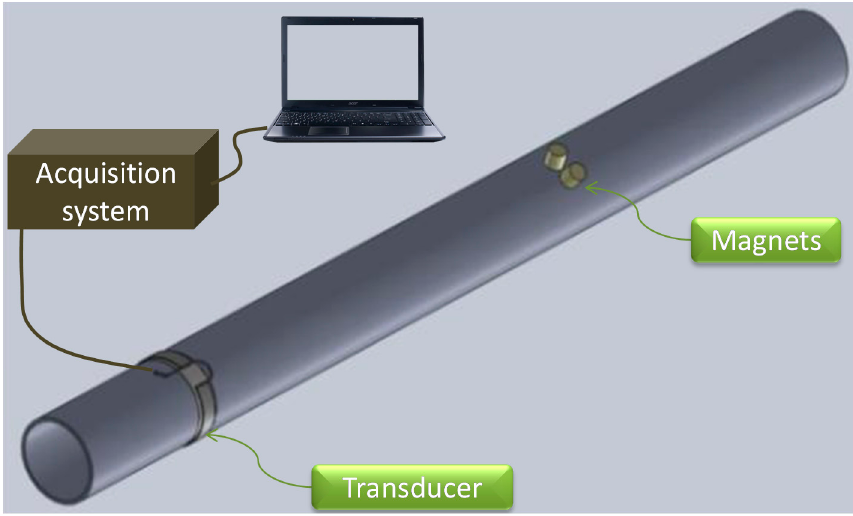
Figure 6. Schematic diagram of the proposed experimental setup shown in Figure 5.